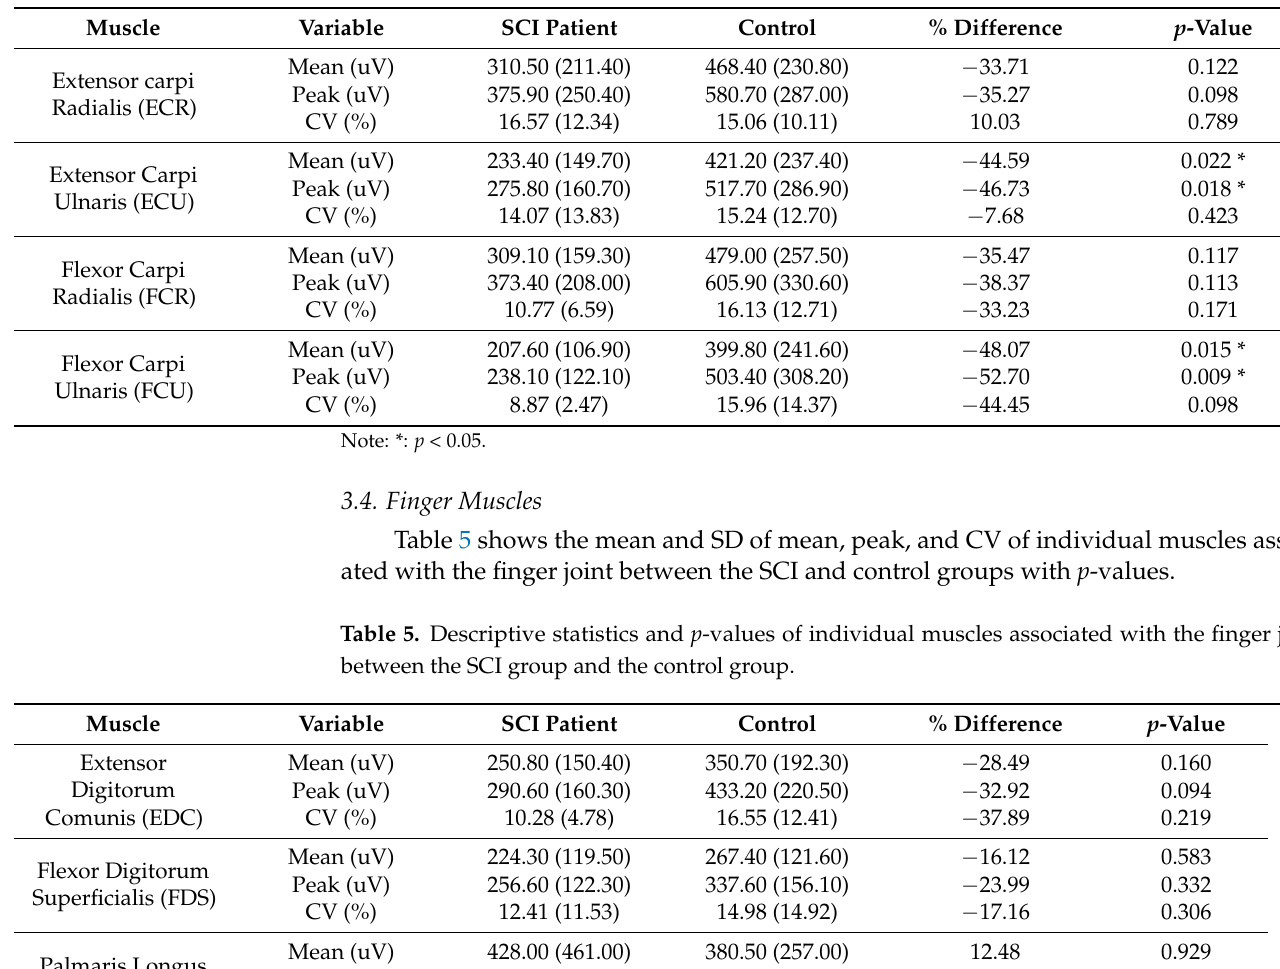
Table 4. Descriptive statistics and p -values of individual muscles associated with the wrist joint between the SCI group and the control group.